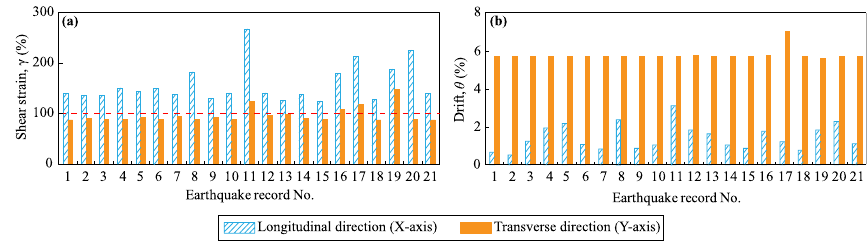
Fig. 8 Peak responses of bridge components for various earthquake records under H